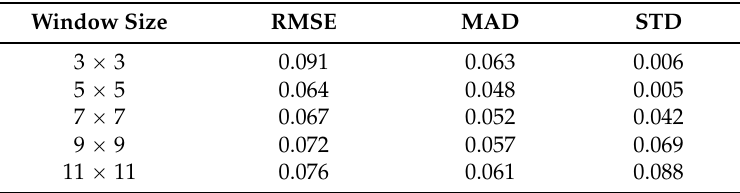
Table 4. Window sizes and responding inversion